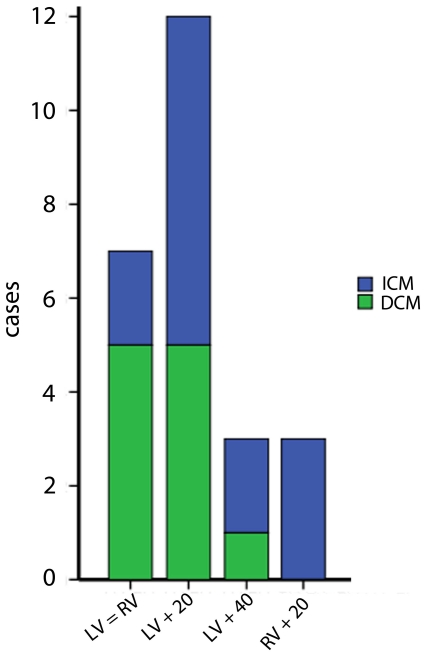
Ventricular-to-ventricular (VV) intervals in patients with ischemic and dilated cardiomyopathy.Number of patients with simultaneous activation of left and right ventricle or sequential inter-ventricular pacing depending on ischemic or dilated cardiomyopathy.